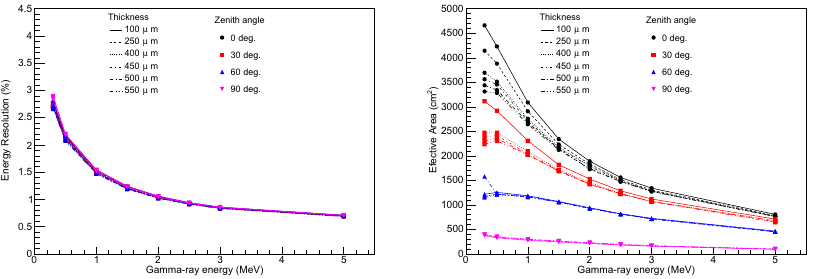
Figure 2: Energy resolution and E ff ective area from the photopeak area